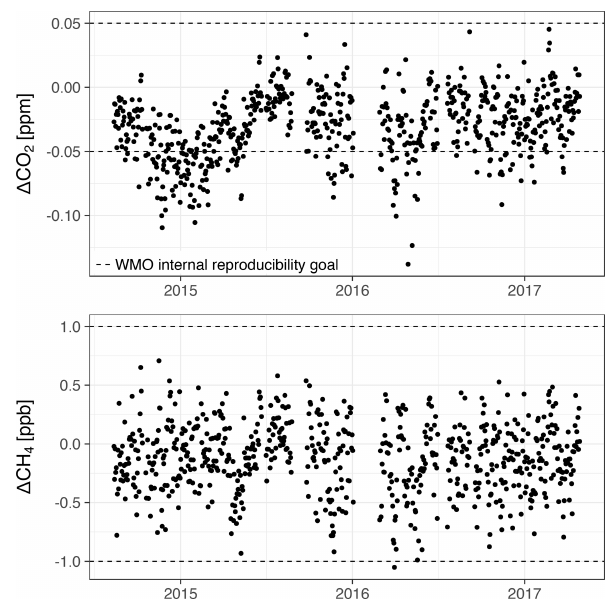
Figure 5. Target tank bias over time for CO 2 and CH 4 . As in Fig. 4, the dashed lines correspond to the WMO internal reproducibility